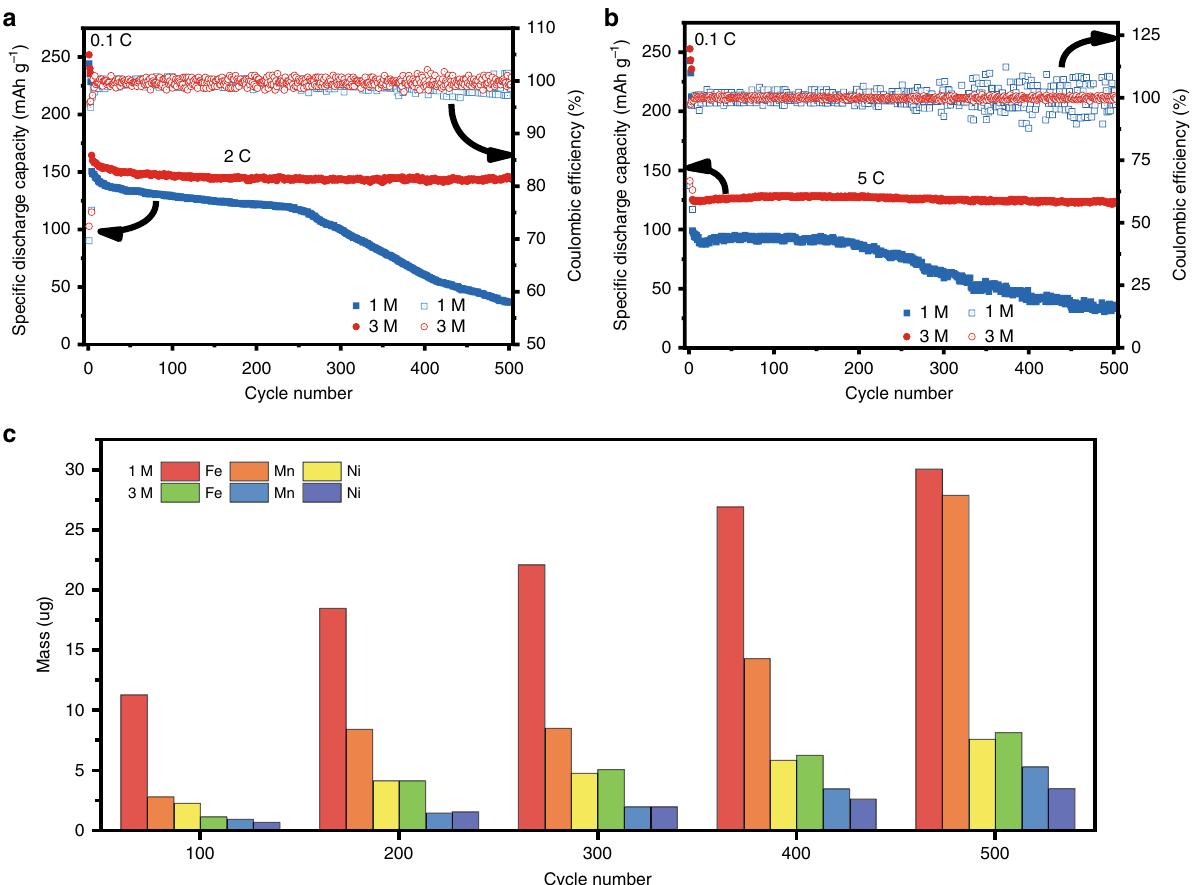
Fig. 4 Rate performance of electrodes at 25 °C and analysis of the deposition of TM. a , b The cycle performance in 1 and 3 M electrolyte at 2C and 5C, respectively; c the amount of transition metal deposited on the different cycled lithium plates in 1 and 3 M electrolytes at